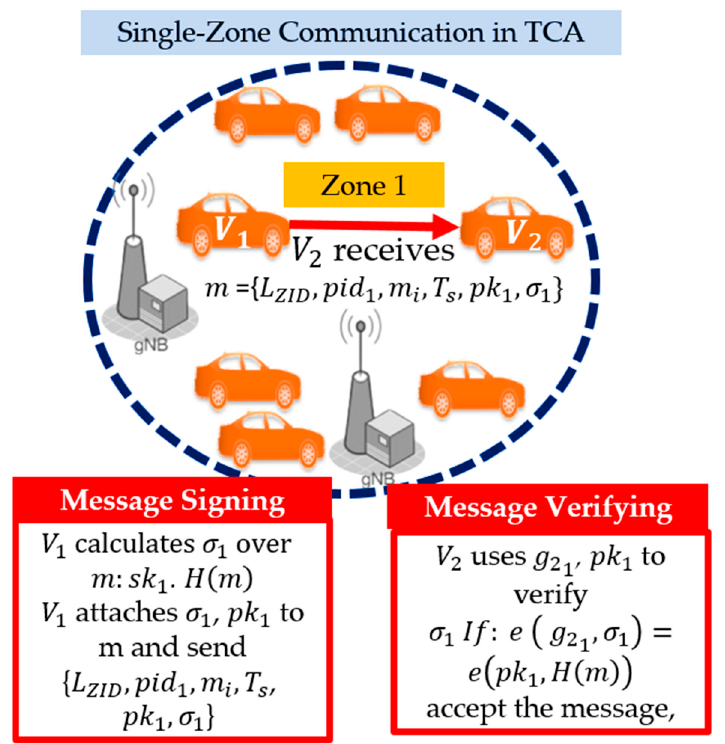
Figure 5. Single-zone communication in the TCA method.